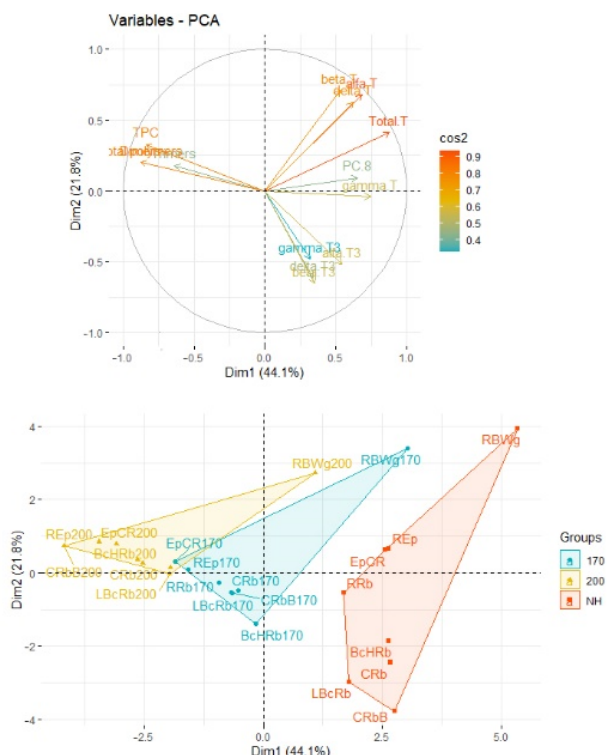
Figure 3. Principal component analysis (PCA) of the loadings plot and the score plot of data from α -, β -, γ -, and δ -tocopherols and tocotrienols, plastochromanol-8 (PC-8), total polar compounds (TPC), and dimers, and trimers of triacylglycerol (TAG) in oil blends heated at 170 °C and 200 °C. NH- not heated, 170 and 200—heated samples.